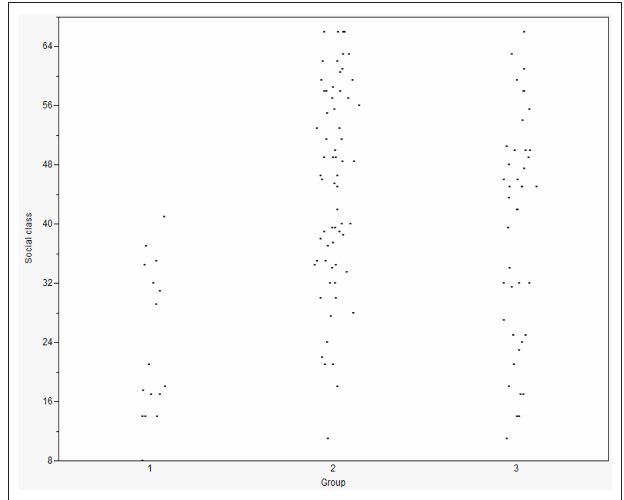
FIGURE 1 | Distribution of social class for the outcome groups at follow-up. 1 = Biphilic/androphilic persisters ( n = 16; M = 23.76, SD = 10.22). 2 = Biphilic/androphilic desisters ( n = 66; M = 44.97, SD = 13.64). 3 = Gynephilic desisters ( n = 42; M = 39.44, SD =